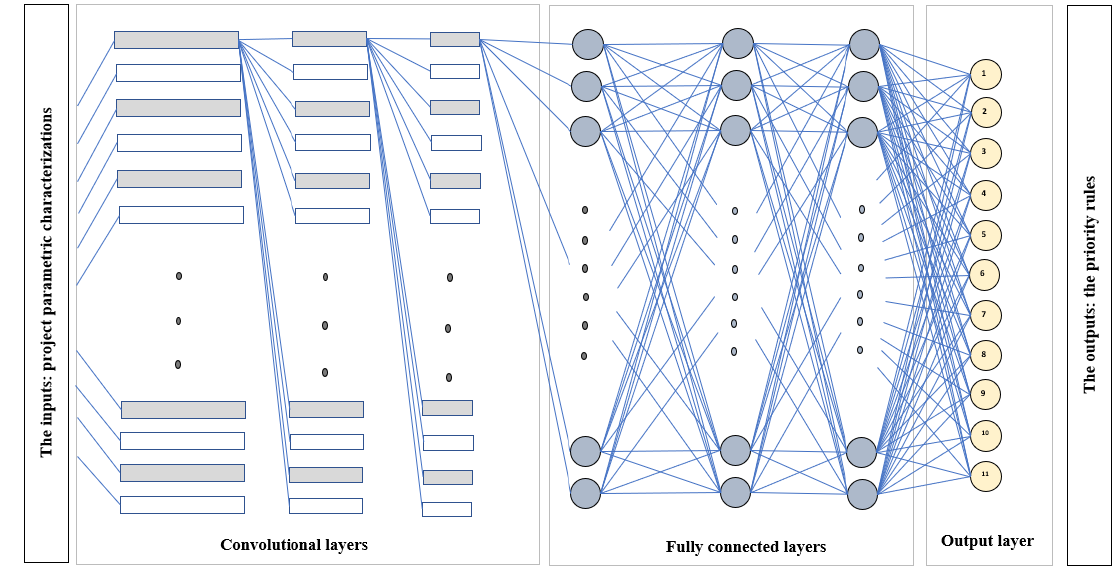
Fig. 1. The developed convolutional neural network(CNN) is composed of eight inputs as input layer, convolutional and fully connected layers, and the output